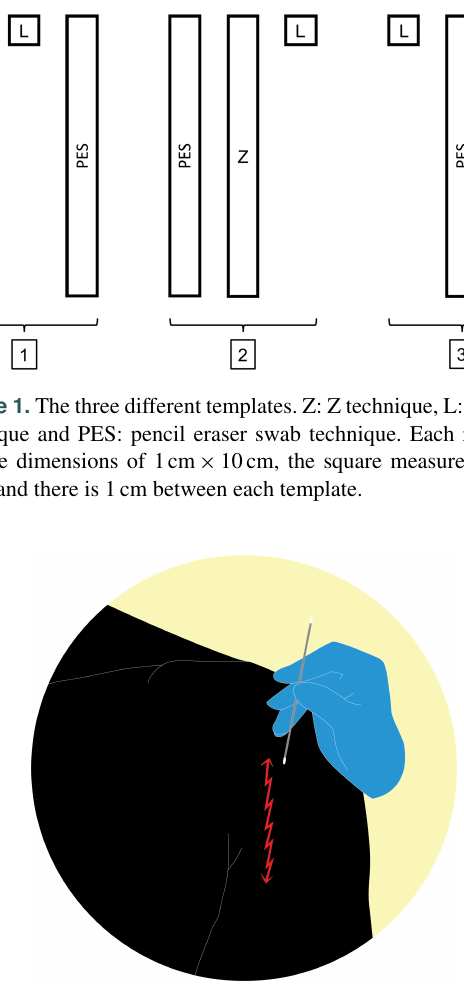
envelope. For swabbing, we use eSwab (Copan Italia